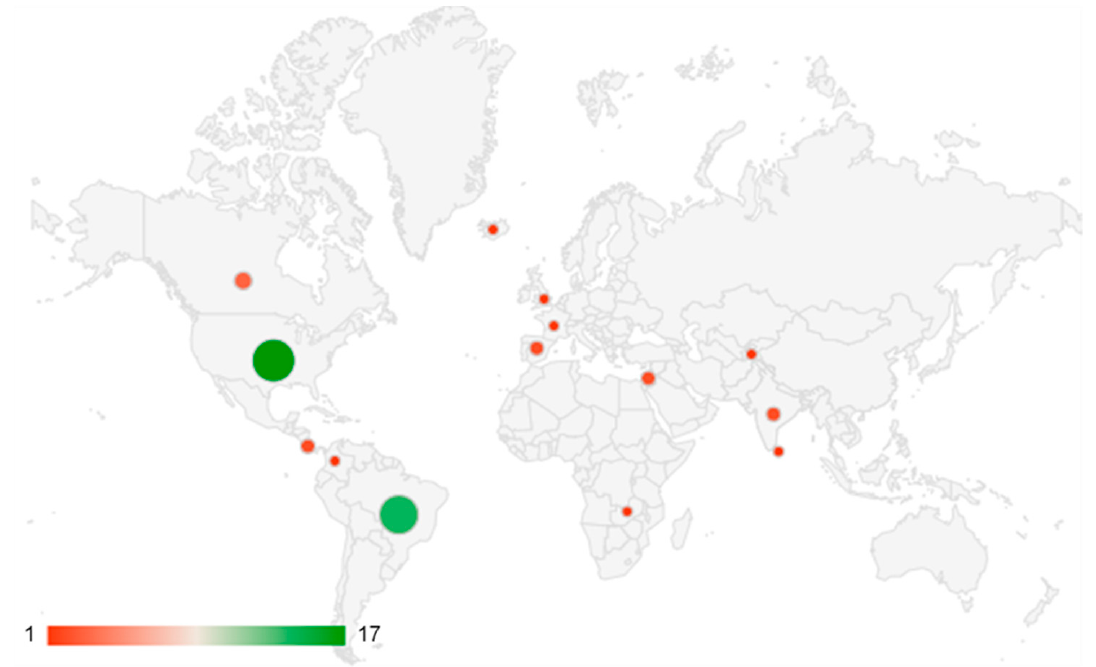
Figure 2. Distribution of surveillance actions developed worldwide identified in the review.